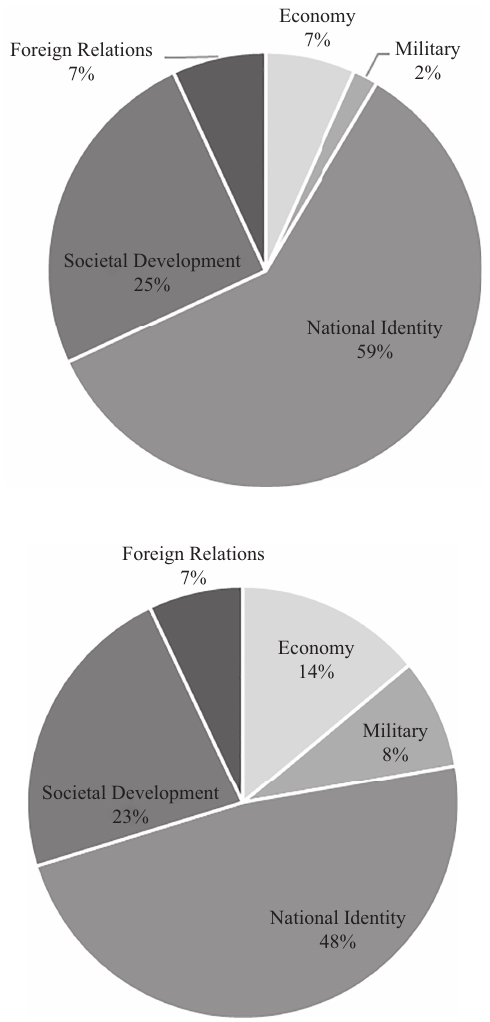
Figure 2. Classification of five categories by percentage –